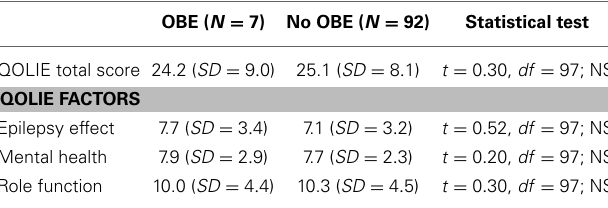
Table 7 | Quality of life among patients with and without out-of-body experiences